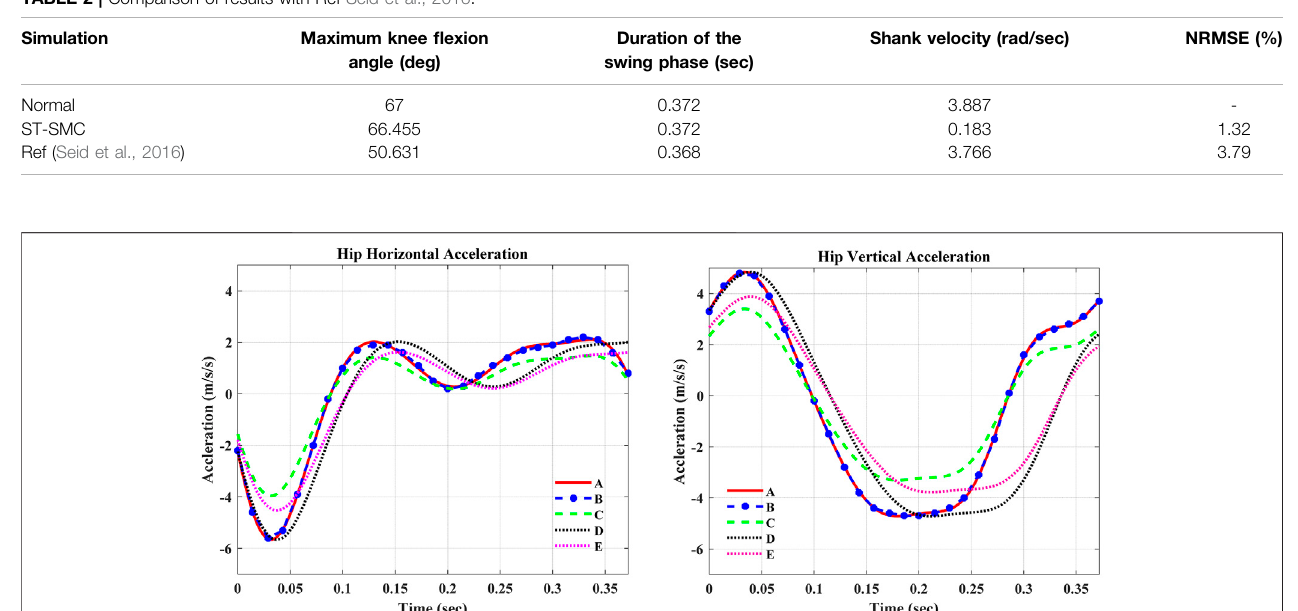
Shank velocity (rad/sec) NRMSE (%)